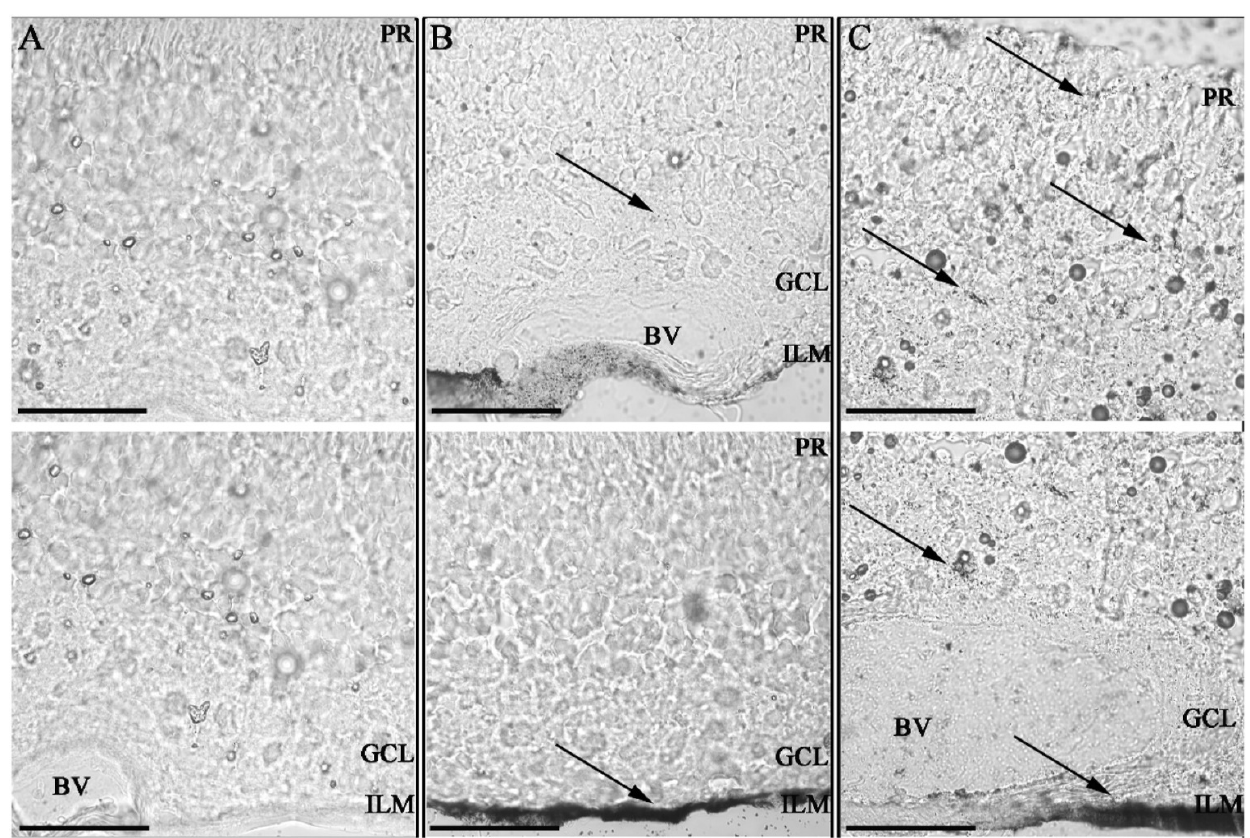
Figure 4. Impact of Hyaluronic acid coating on tissue invasion in porcine retinal explants. Retinal explants imaged with Confocal bright field microscopy at 63× magnification after silver staining with 100 nm scale bars; ILM = inner limiting membrane; GCL = ganglion cell layer; PR = photoreceptor layer and BV = blood vessel. Two sequential histological porcine retina per sample. Control non-treated retina ( A ) retinas 24 h after administration of GNPs ( B ) and HA-GNPs ( C ) at a concentration of 0.5 mM. Gold ENMs show a dotted black pattern inside the tissues with accumulation occurring at the administration point in the ILM and spreading to other tissues only for those ENMs functionalized with hyaluronic acid. This work by Apaolaza et al. highlights the impact ENM functionalization can have on biodistribution and subsequent opportunities for toxicity. Reprinted with permission from [96]. 2020, Elsevier.